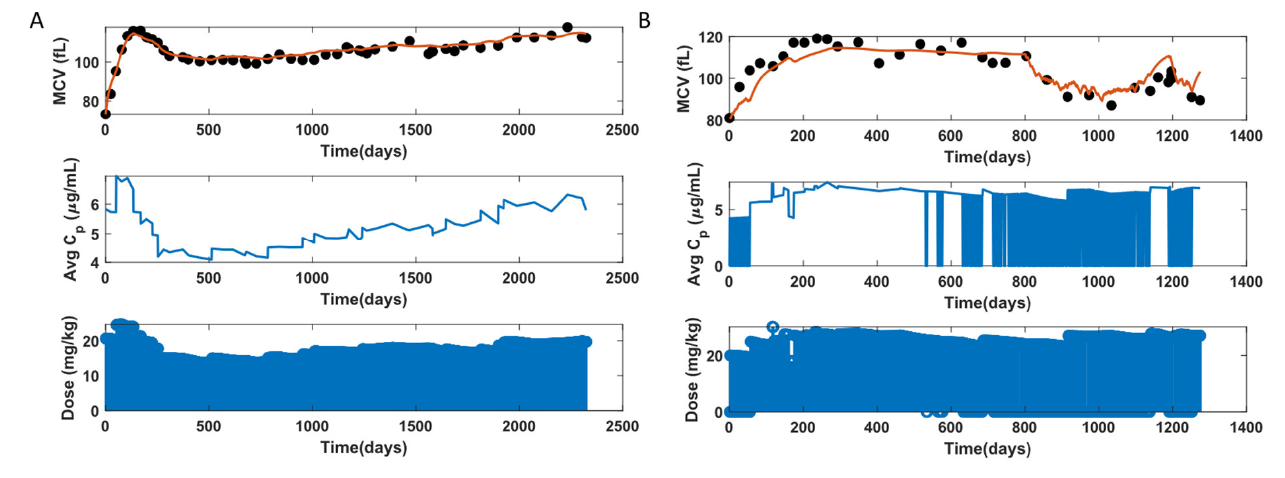
Figure 11. MCV model fit to data for two representative participants. ( A ): Adherent, ( B ): Non-adherent.